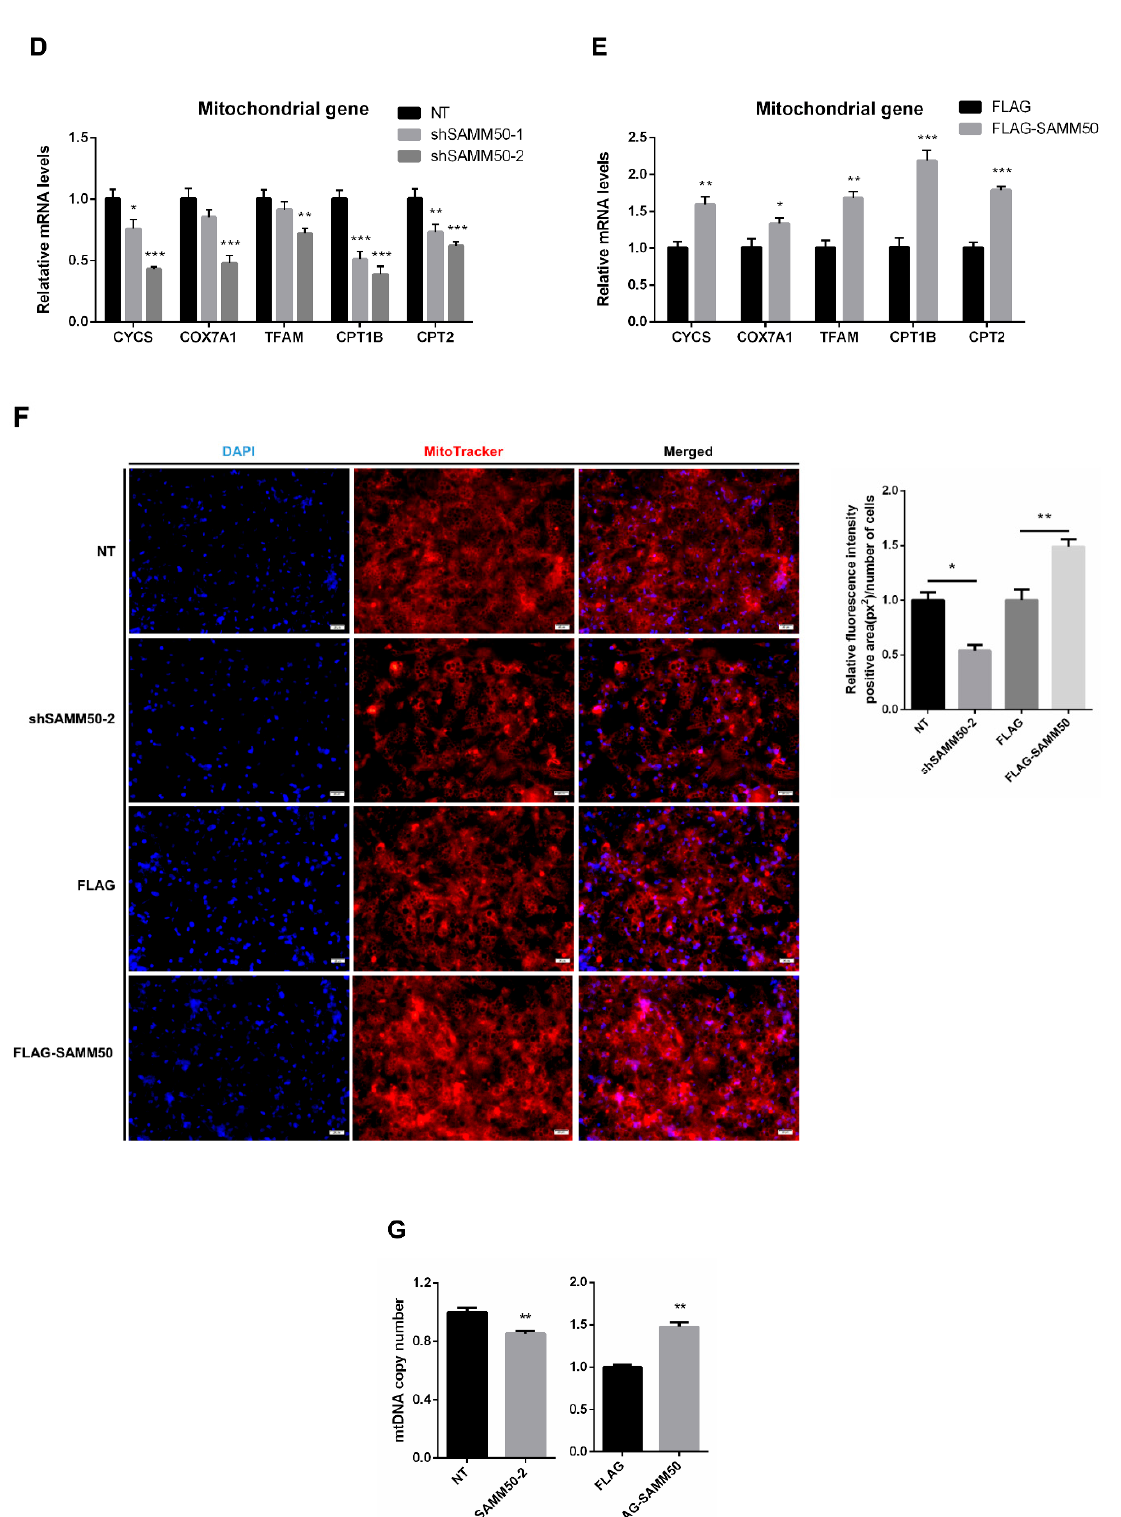
Figure 4. Effects of SAMM50 knockdown and overexpression on the mitochondrial dynamics and biogenesis of beige adipocytes. ( A , B ) Relative mRNA levels of mitochondrial fusion ( A ) and fission ( B ) genes in beige adipocytes infected with shSAMM50 and FLAG-tagged SAMM50 were analyzed by qPCR. ( C ) The expression ratio of fusion/fission was calculated as the ratio of fusion genes to fission genes. ( D , E ) The expression levels of mitochondrial genes in beige adipocytes infected with